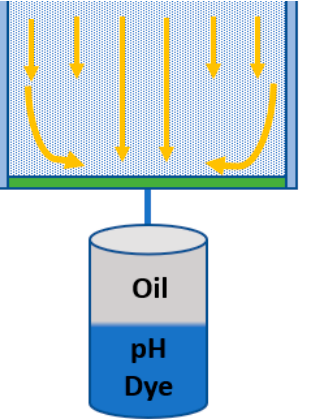
Figure 10. Estimated CO 2 front (yellow arrows) reached the bottom of the 3-dimensional (3-dim) column and flow into the sapphire cell.